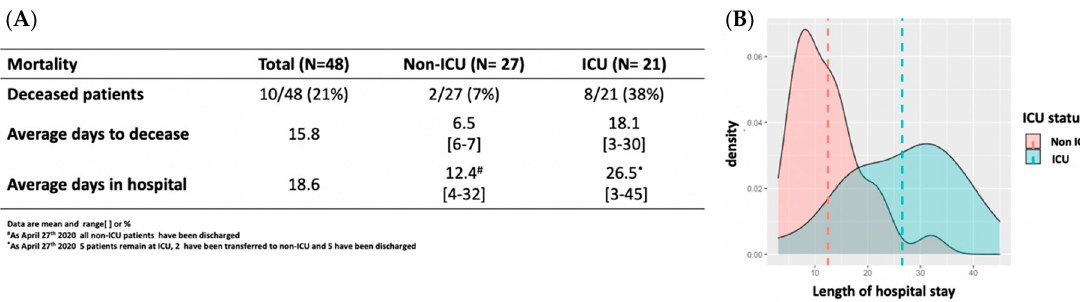
Figure 1. Chest X-ray images from all the deceased intensive care unit (ICU) patients. Most of the patients presented bilateral pneumonia at triage.